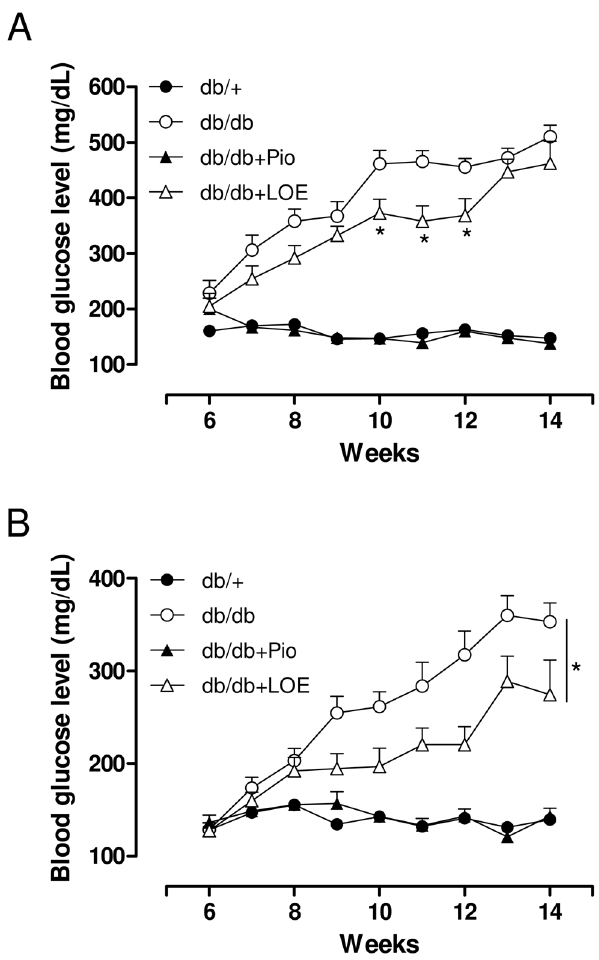
Figure 1. LOE and pioglitazone treatments improve blood glucose levels in db/db mice. (A) Non-fasting and (B) fasting blood glucose levels from week 6 until week 14. All groups were fasted for 4 h before blood samples were taken. Values are shown as means 6 S.E.M. (n=13–14). * P , 0.05 indicates a significant difference versus db/db group.